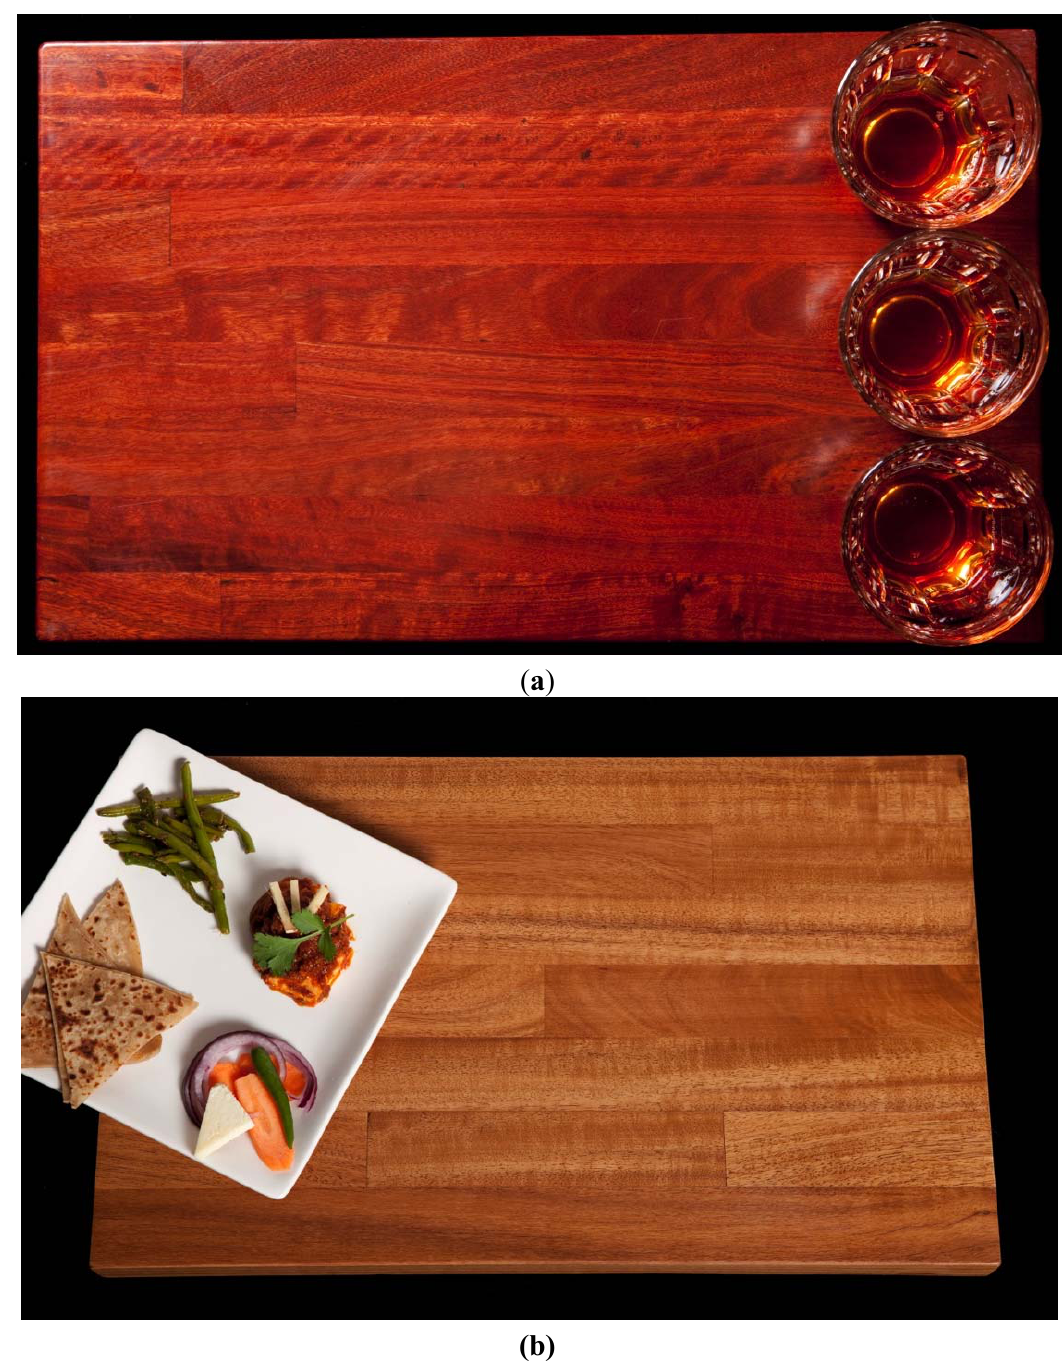
Figure 4. ( a ) Spirits on “rosewood”. A laminated board from old-growth riverine E. camuldulensis from Mildura on the New South Wales/Victoria border in Australia; ( b ) Feeding on dreams. Laminated “NZ teak” from New Zealand grown E. bosistoana ; ( c ) The symbolism in the fretwork in this Imperial table reflects cultural tradition and status. Fine modern interpretations of older styles still need elite